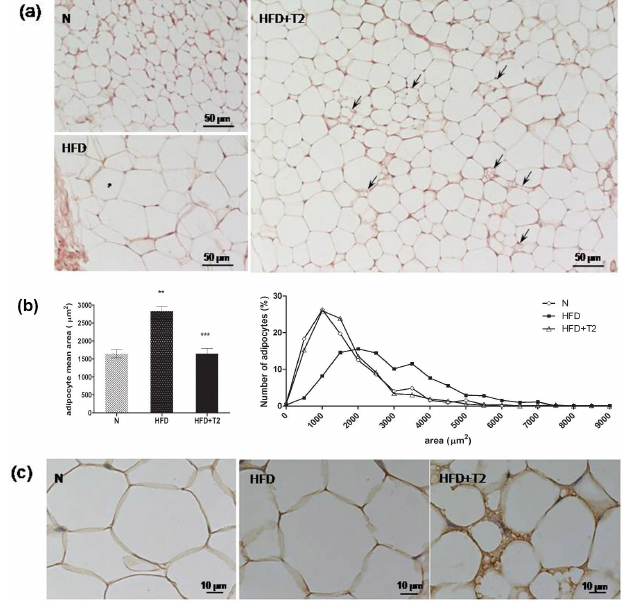
Figure 3. Effects of T 2 administration on sWAT morphology. ( a ) Histological analysis, ( b ) morphometrical analysis, and ( c ) UCP1 immunohistochemistry of anterior sWAT of N, HFD, and HFD+T 2 rats. Adipocytes from HFD rats are significantly larger than those from N rats. After T 2 administration, the mean area and frequency distribution of the adipocytes were normalized to control values. A number of UCP1-stained paucilocular adipocytes are shown (arrows and panel ( c )). More than 720 adipocytes were quantified from N = 3 rats from each group. Data are presented as Means ± SEM. ** p < 0.01 vs. N; *** p < 0.001 vs.